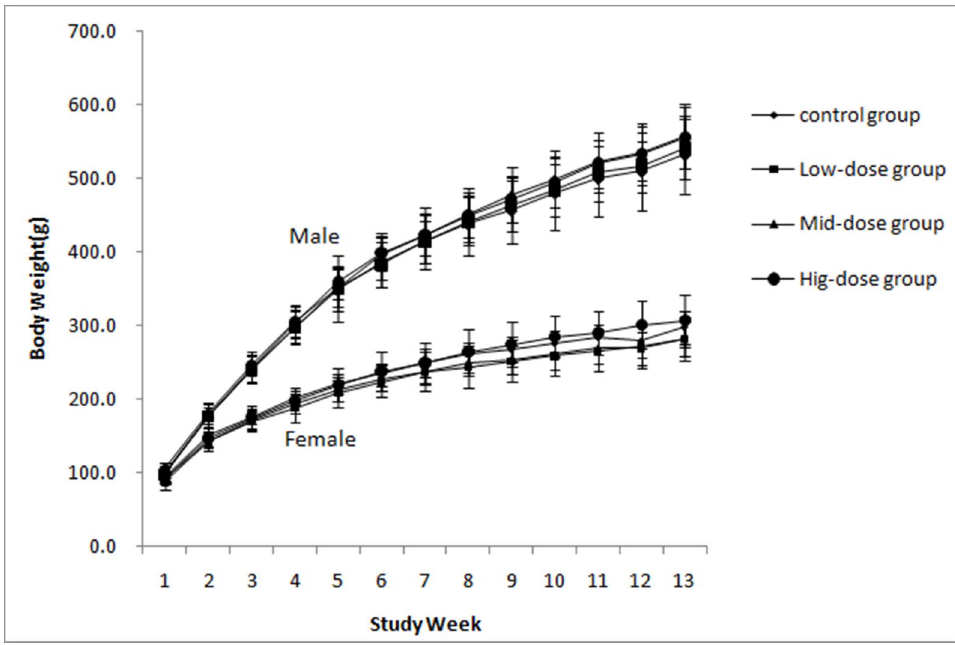
Figure 1. Mean weekly body weight of rats. doi:10.1371/journal.pone.0106470.g001 PLOS ONE |